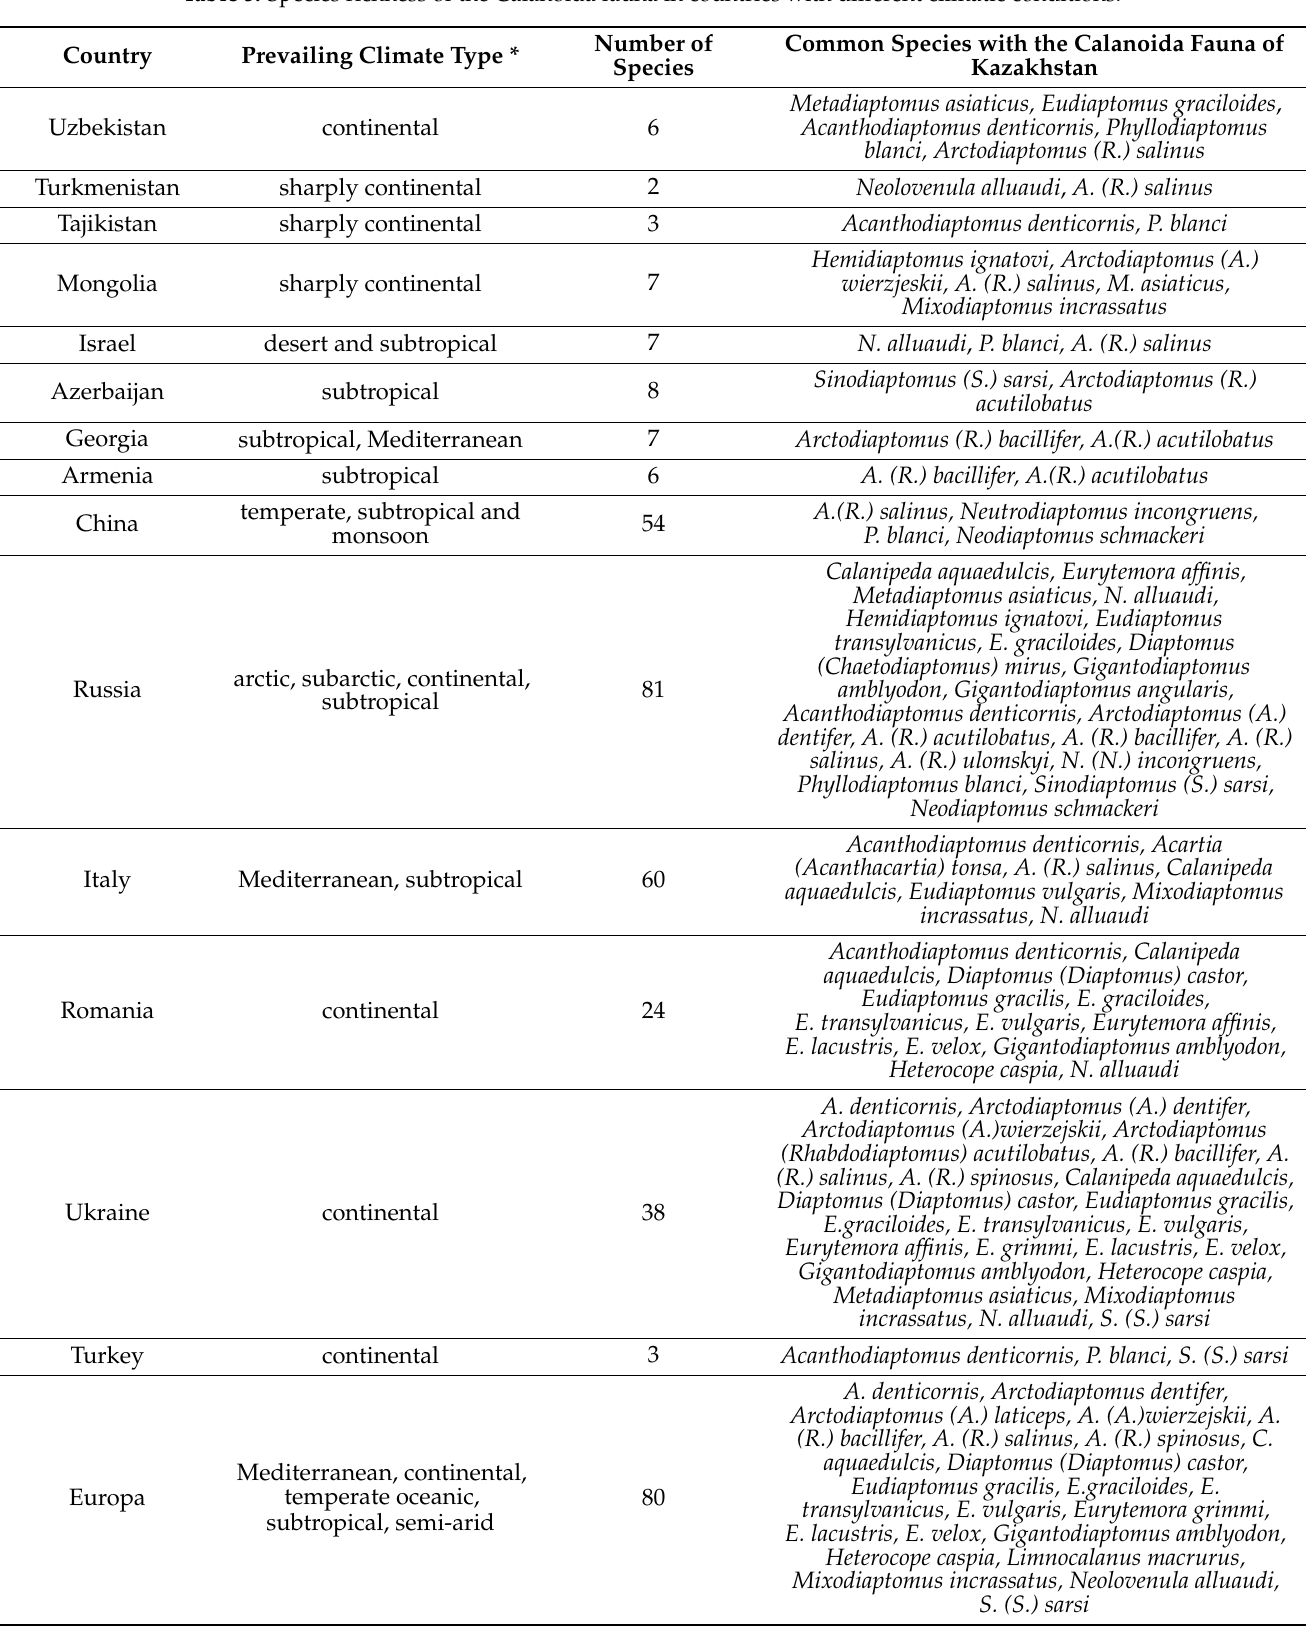
Table 5. Species richness of the Calanoida fauna in countries with different climatic